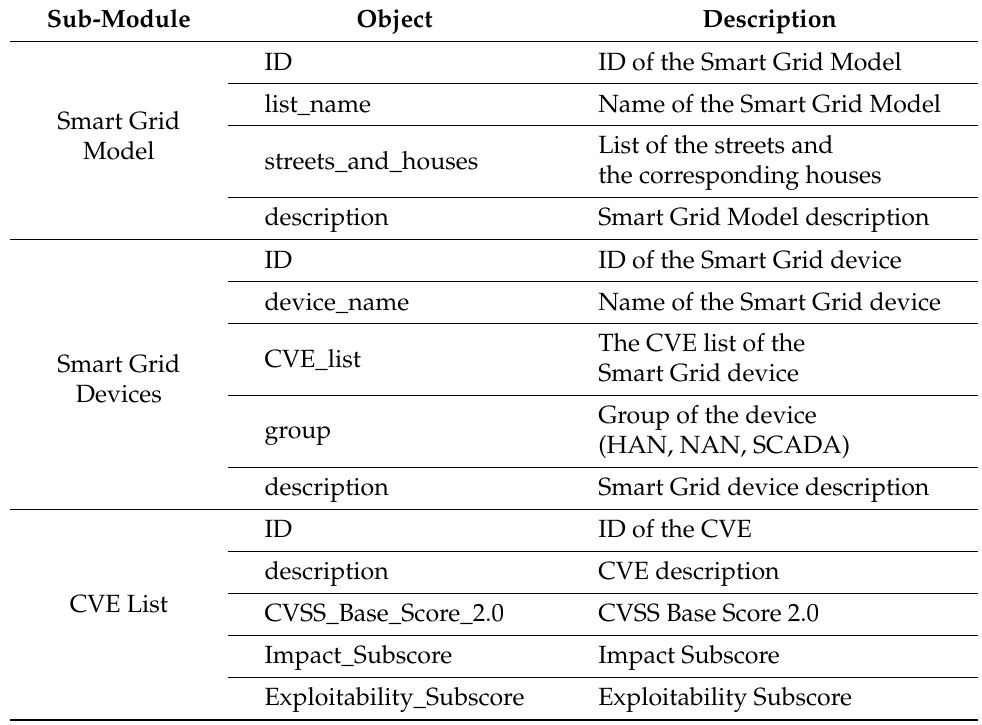
Table 1. The database structure of